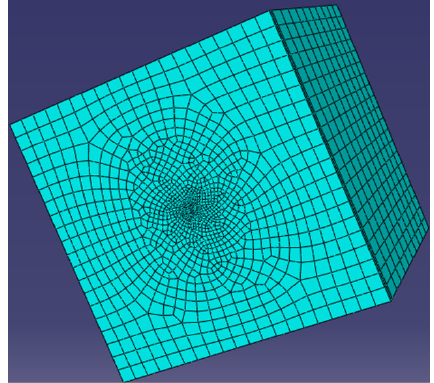
Figure 3. Finite element mesh.